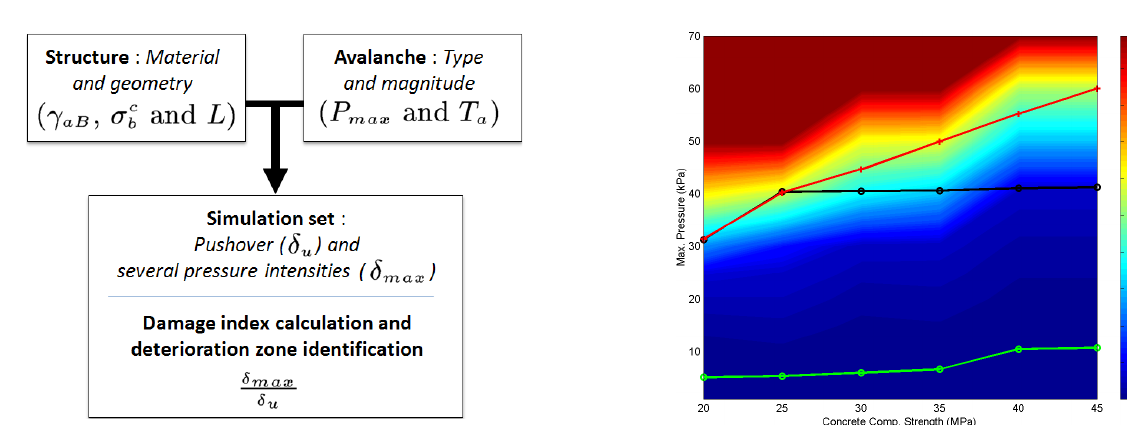
Fig. 14. Distribution of maximum compressive strain ( (cid:15) c ( p ) (resp. ACP), which means B efore (resp. A fter) the C ompression P eak, describes simulations where (cid:15) c ( p ) value related to the maximum compressive stress inside concrete. If (cid:15) c collapse of the structure.